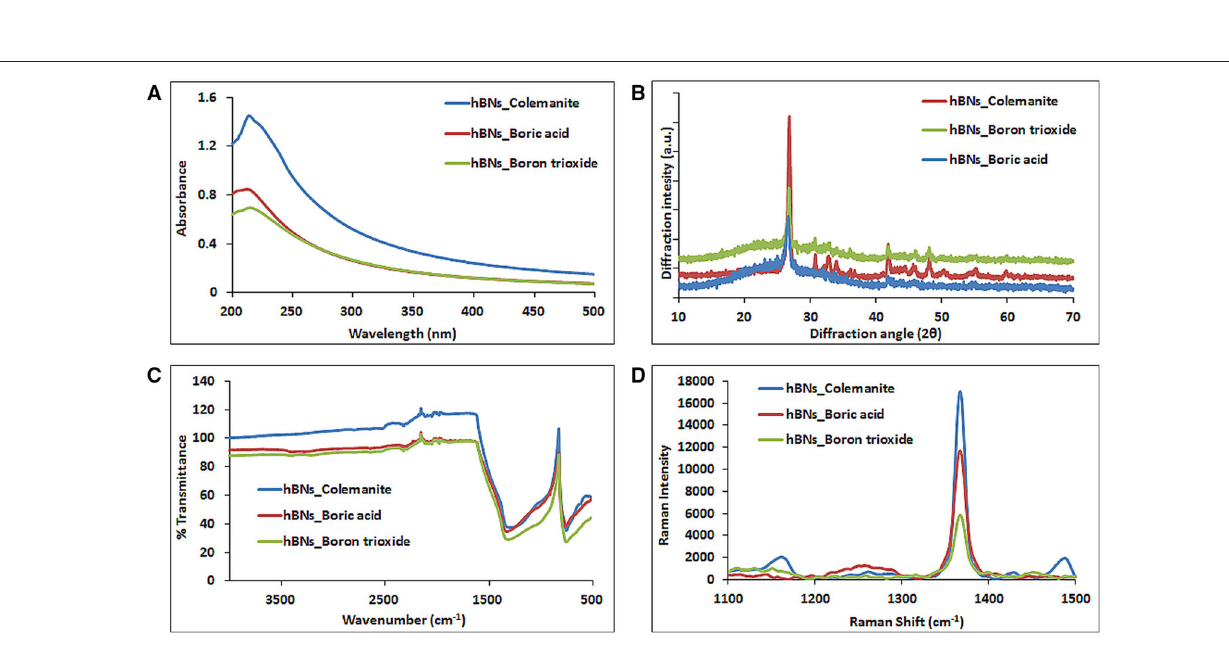
Frontiers in Bioengineering and Biotechnology | www.frontiersin.org